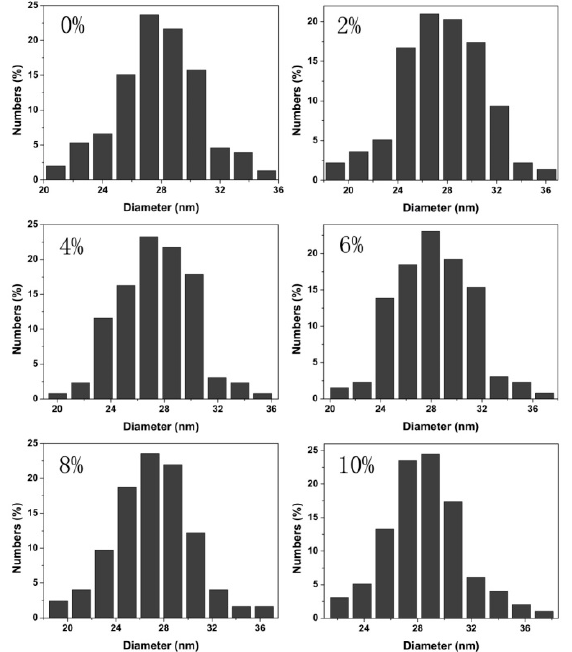
Figure 3. The TEM photo and the size distribution histogram of YF 3 :Eu 3+ nanocrystals.